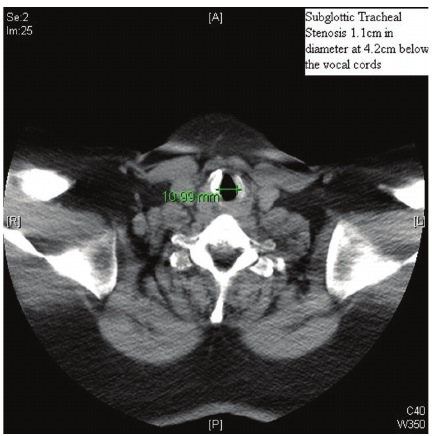
Figure 1: CT SCAN of subglottic tracheal stenosis.